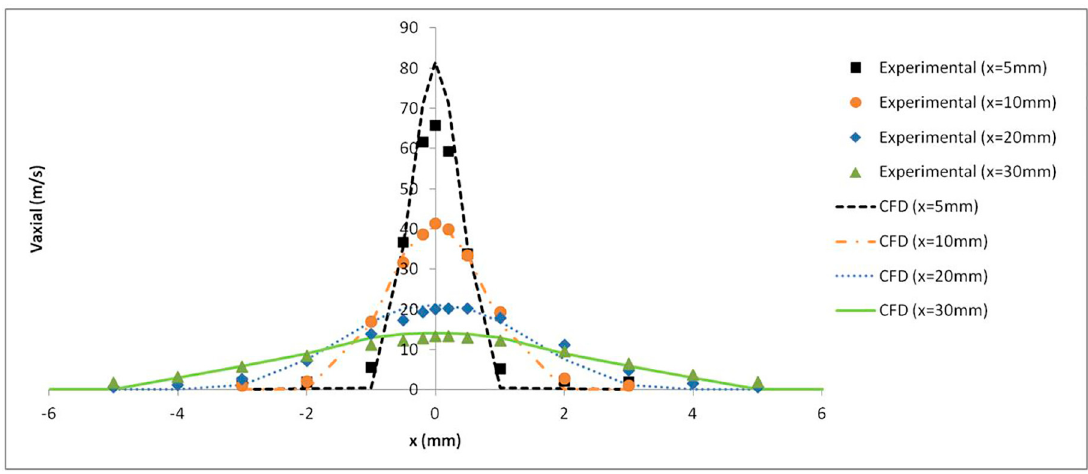
Figure 11. Experimental and numerical axial air velocity profiles at different distances from the catheter tip.